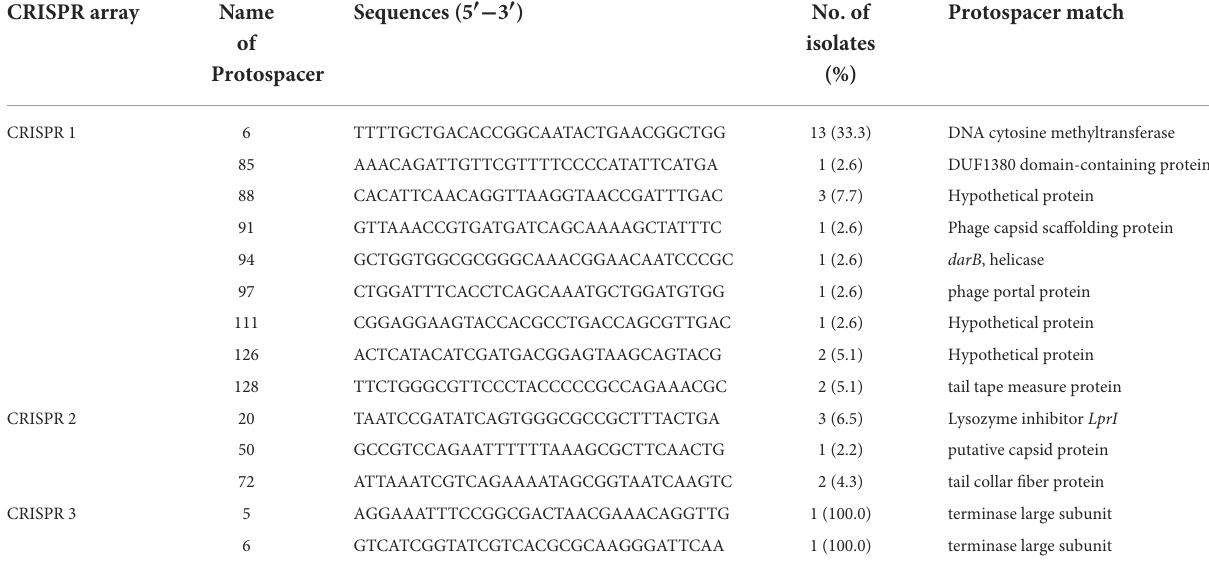
TABLE 3 Protospacer matching plasmids and phages, and spacer sequences in 49 third- or fourth- generation cephalosporin-resistant avian pathogenic E. coli isolated from five integrated broiler operations. CRISPR